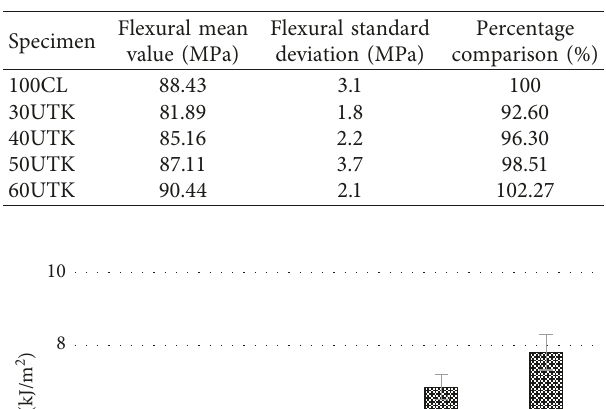
Figure 5: Flexural strength (MPa) vs. fiber content. Table 3: Detail values for flexural strength.